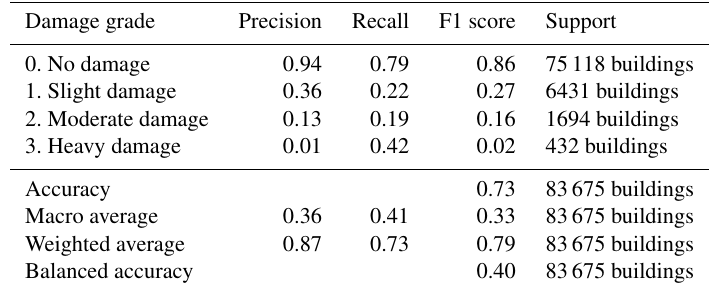
Table 8. Test-set performance metrics for multi-class classification for the 2020 Zagreb earthquake. Damage grade